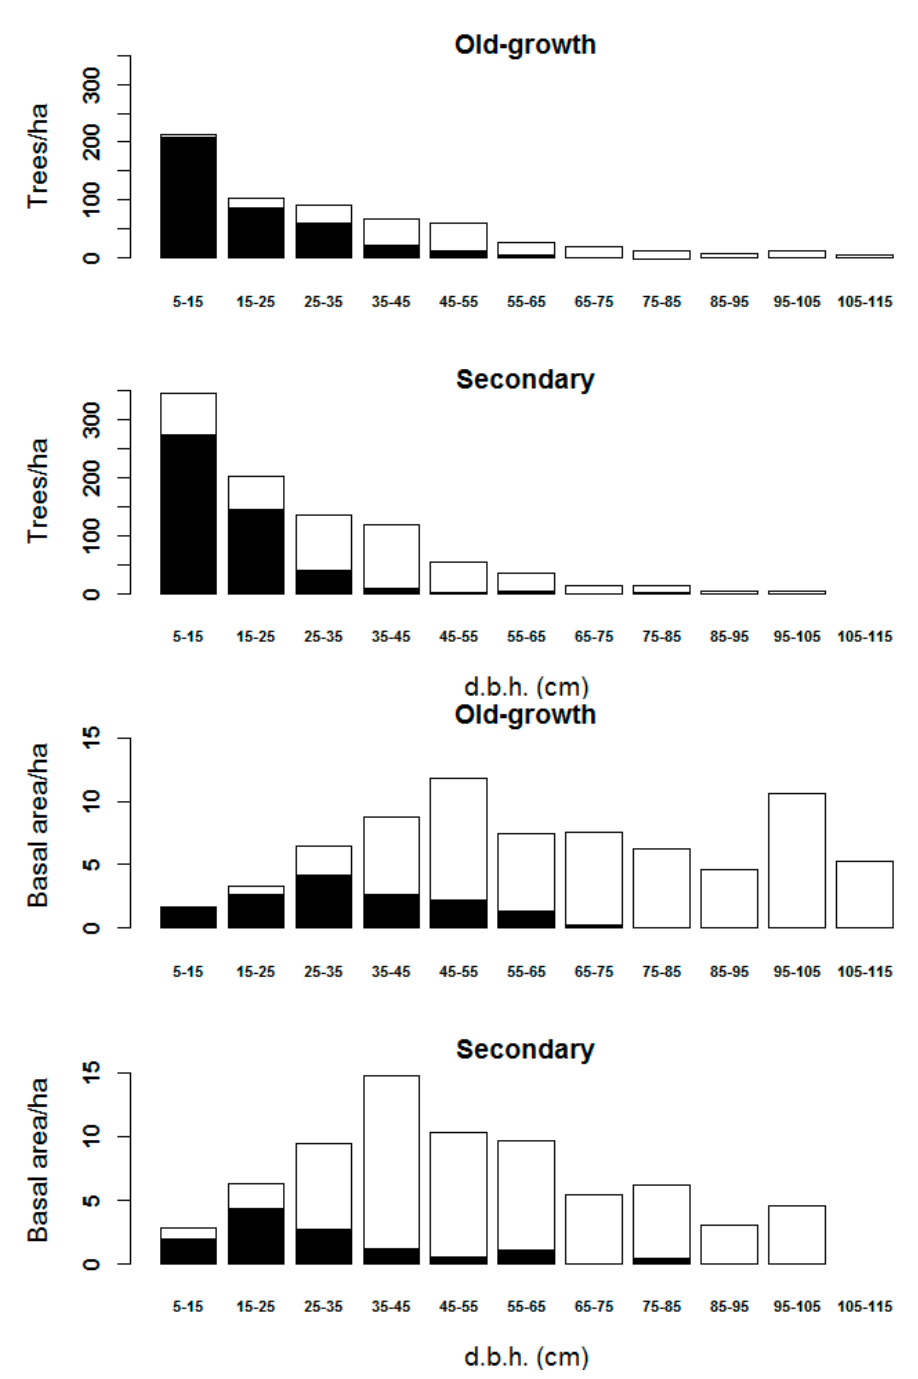
Figure 5. Basal area (BA, m 2 ) and density (trees ha − 1 ) effectively detected from unmanned aerial vehicle (UAV) imagery for each diameter class (DBH, cm). Ground-based values represented by